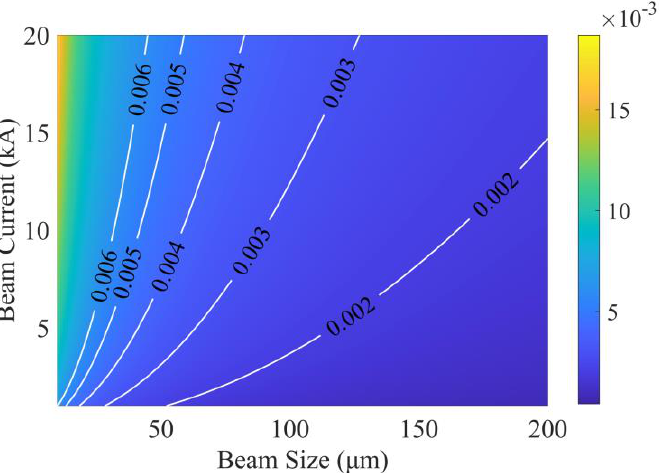
Figure 3. The Pierce parameters for different currents and transverse sizes.